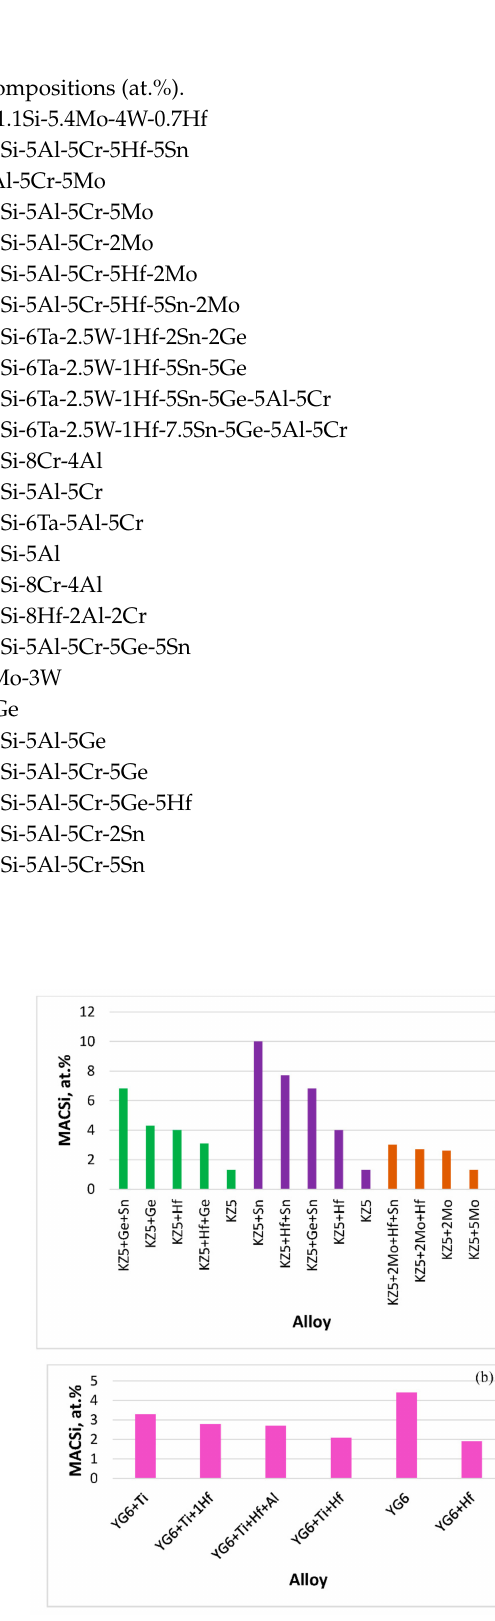
Figure A1. Si macrosegregation (MACSi) in ( a ) Ti-rich (Ti concentration about 24 at.%) and ( b ) Ti-poor (Ti concentration about 11 at.%) Nb-silicide-based alloys. Base alloy in ( a , b ), respectively, KZ5 (Nb-24Ti-18Si-5Al-5Cr [1,61]) and YG6 (Nb-20Si-5Mo-3W)